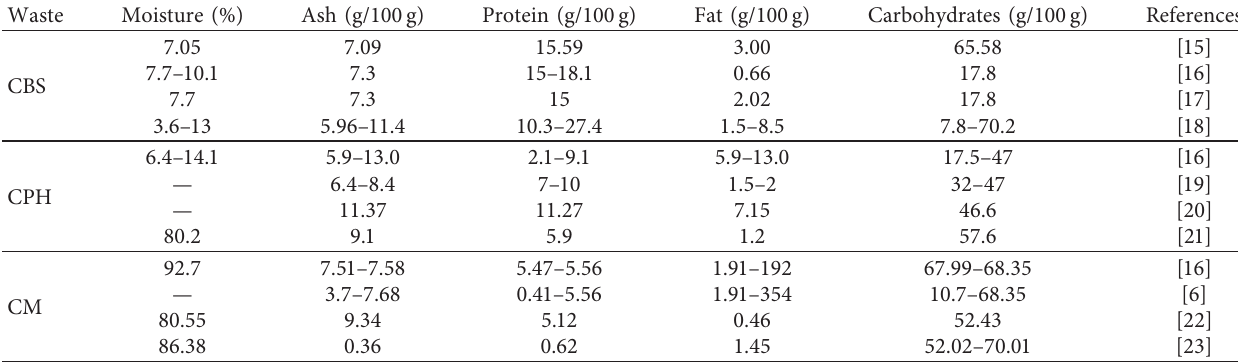
Table 1: Chemical composition of cocoa wastes.